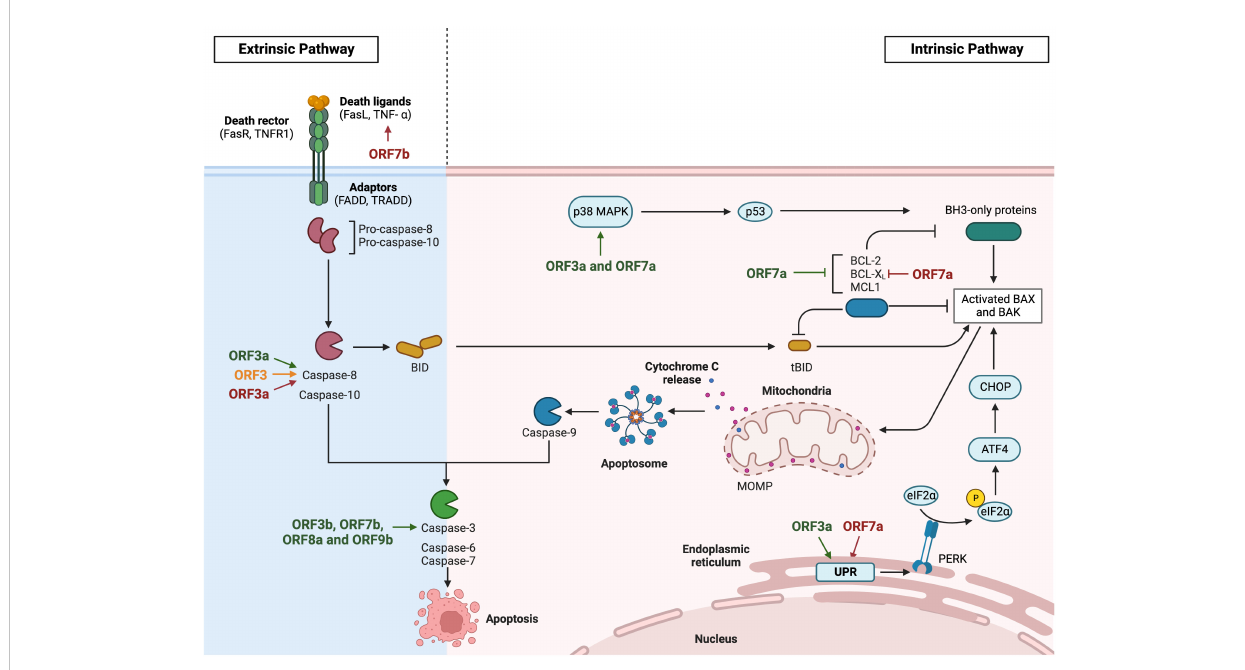
FIGURE 4 Modulation of apoptosis by HCoVs accessory proteins. Diagram representing the extrinsic and the intrinsic apoptosis pathway via death ligand recognition or viral induction respectively. The apoptosis inductor CHOP activation is represented via unfolded protein response. SARS-CoV accessory proteins are represented in green, MERS-CoV in orange and SARS-CoV-2 in red. Images created with